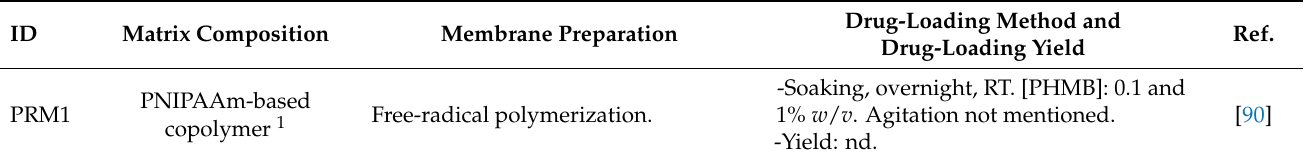
Table 3. Composition and methods employed in the preparation of PHMB-releasing membranes (PRMs) developed for antimicrobial dressings